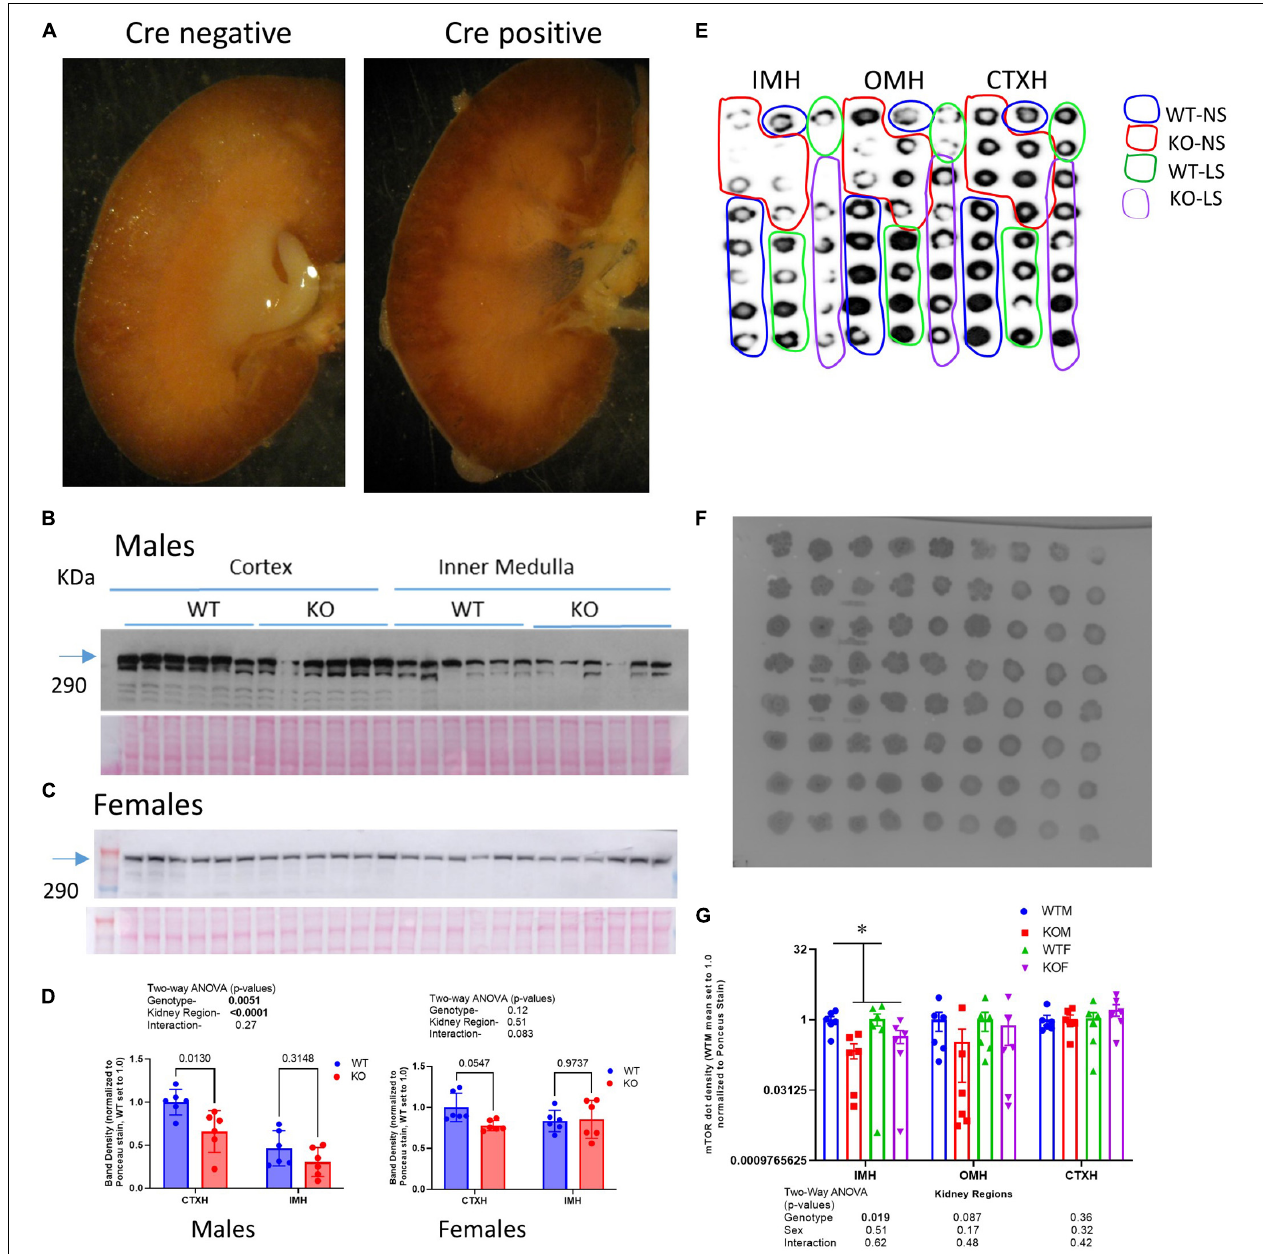
FIGURE 1 | Characterizing the CD-principal-cell targeted mTOR deletion. (A) To evaluate cellular location of Cre-recombinase activity, LacZ reporter mice were crossed with Aqp2 cre transgenic mice and the kidneys of offspring probed for β -galactosidase activity- blue stain; left (Cre-negative); right (Cre-positive) demonstrating staining specific to renal collecting duct in Cre positive mice. mTOR CD-KO mice were generating by crossing male Mtor tm 1 . 2 Koz /J with female Aqp2 cre mice. Western blots of cortex and inner medulla homogenates (equal amounts of protein were loaded in each lane, 10 µ g/lane) from wild-type (WT) and knockout (KO) (B) male and (C) female mice ( n = 6/group) probed with anti-mTOR polyclonal antibody; (D) densitometric summaries of western blotting of mTOR in cortex (CTXH) and inner medullary homogenates (IMH, mean ± sem); (E) dot blot of inner medulla (IMH), outer medulla (OMH), and cortex (CTXH) homogenates (2 µ l/dot) from WT and KO male and female mice ( n = 6/group) probed with anti-mTOR antibody. (F) Ponceau S staining of proteins on dot blot for loading correction of mTOR dot blot; (G) density summary of dots normalized by Ponceau intensity. Two-way ANOVA (genotype × sex) is shown below bars; ∗ indicates a significant ( p < 0.05) difference between WT and